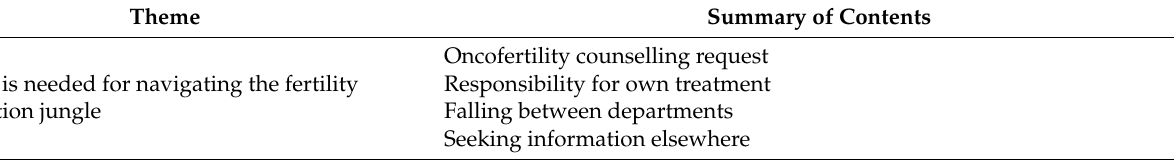
Table 3. Results from the qualitative interview divided into three